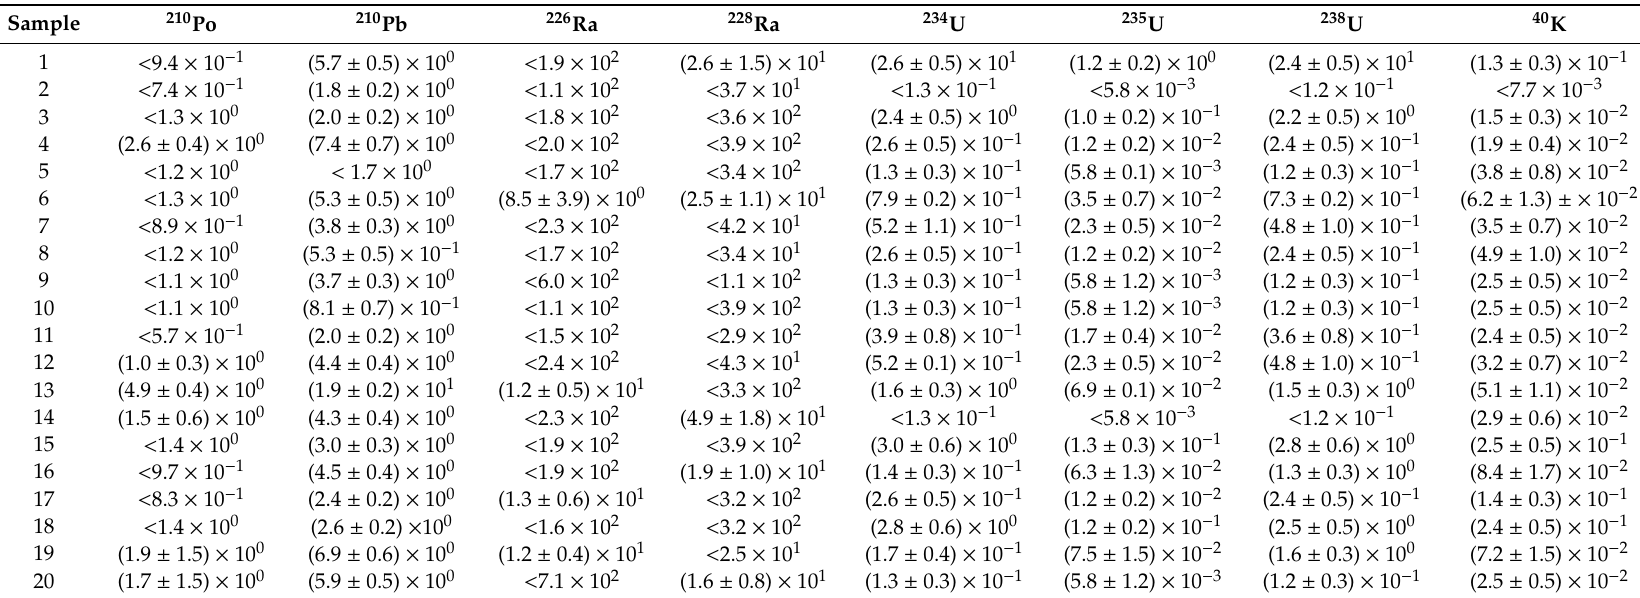
Table 3. Radionuclide activity concentration and standard uncertainty ( k = 1) values in bottled water (mBq /